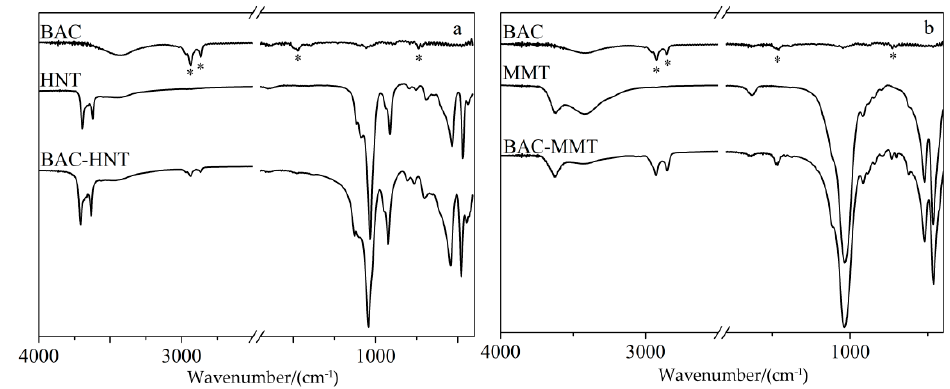
Figure 4. The FT-IR spectra of HNT ( a ) and MMT ( b ) loaded BAC before and after. Table 1. Wavenumbers and assignments of the FT-IR vibration